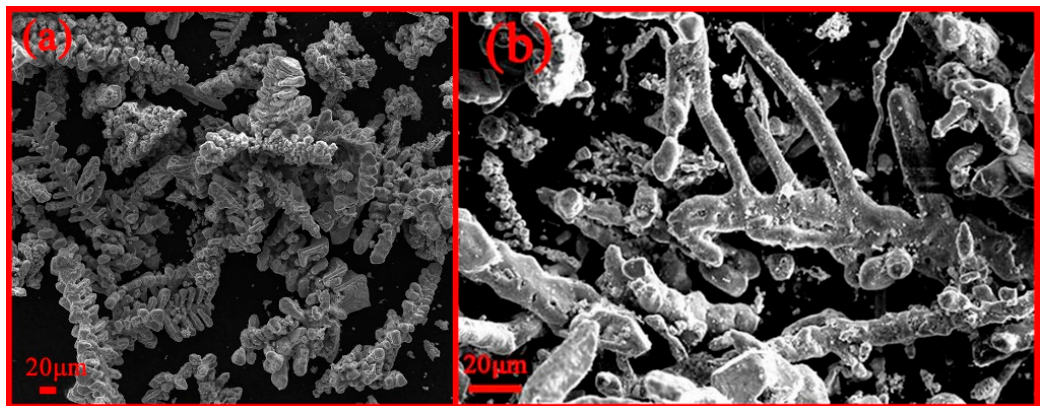
Figure 4. SEM analysis of electrodeposited products under different electrolysis voltages: ( a ) 2.0 V; ( b ) 2.3 V.